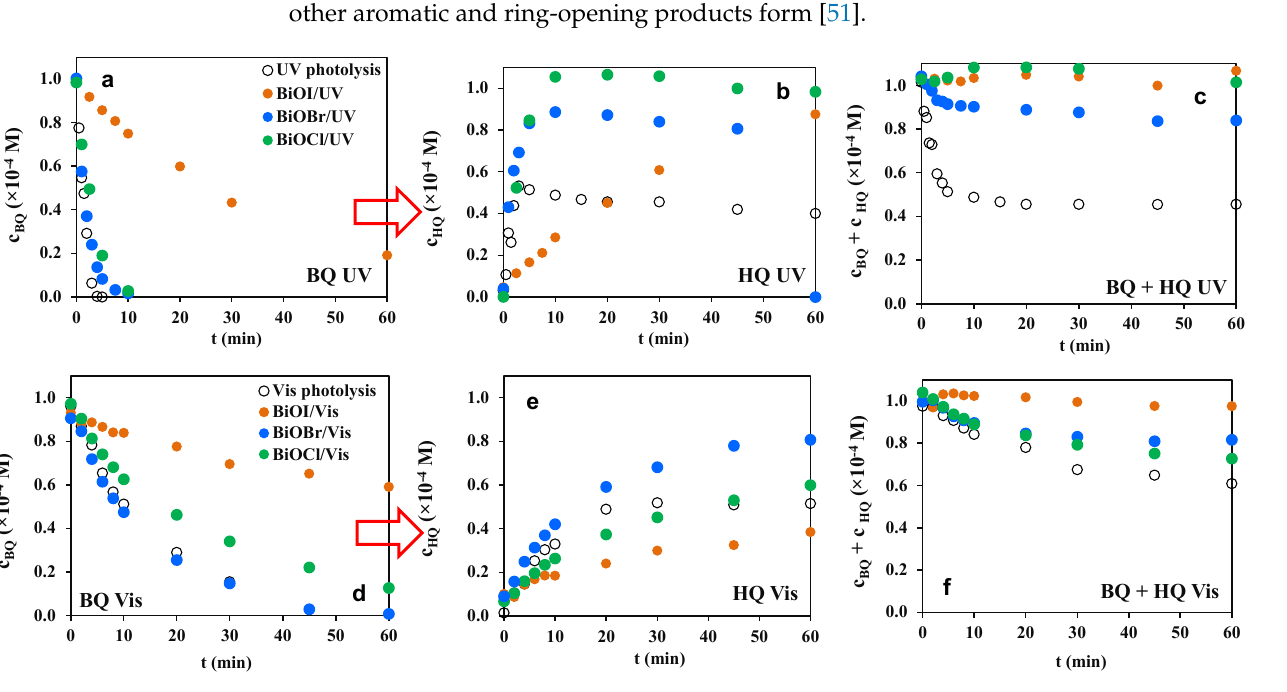
Figure 2. Transformation of BQ ( a , d ) and formation of HQ ( b , e ) and the sum of the BQ and HQ concentration ( c , f ) in O 2 -free BiOX suspensions, under UV ( a – c ) and Vis ( d – f ) radiation ( a , d ). Based on the bandgap energy (Table 1), BiOI and BiOBr can be excited with 398 nm photons, but not BiOCl, while only BiOI can be excited using a Vis LED. Nevertheless, in the case of UV LED, the transformation of BQ occurred at a rate similar to that of photolysis radiation. Both catalysts were blackened under irradiation; this change was reversi-